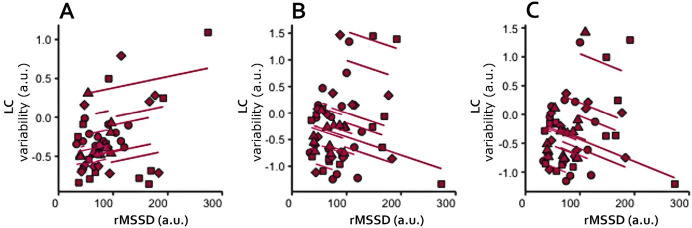
Relationship between LC variability and rMSSD across the task stages for each preprocessing pipeline.Note: (A) spatially normalized pipeline (not significant, p-value=0.312, CI (95%) = [−0.175, 0.483]). (B) FIXed + explicit Resp pipeline (trend-level negative association, Rrm = −0.29, p=0.07, CI (95%) = [−0.558, 0.033]). (C) FIXed + explicit Phys pipeline (significant, Rrm = −0.411, p=0.009, CI (95%) = [−0.649,–0.1]).